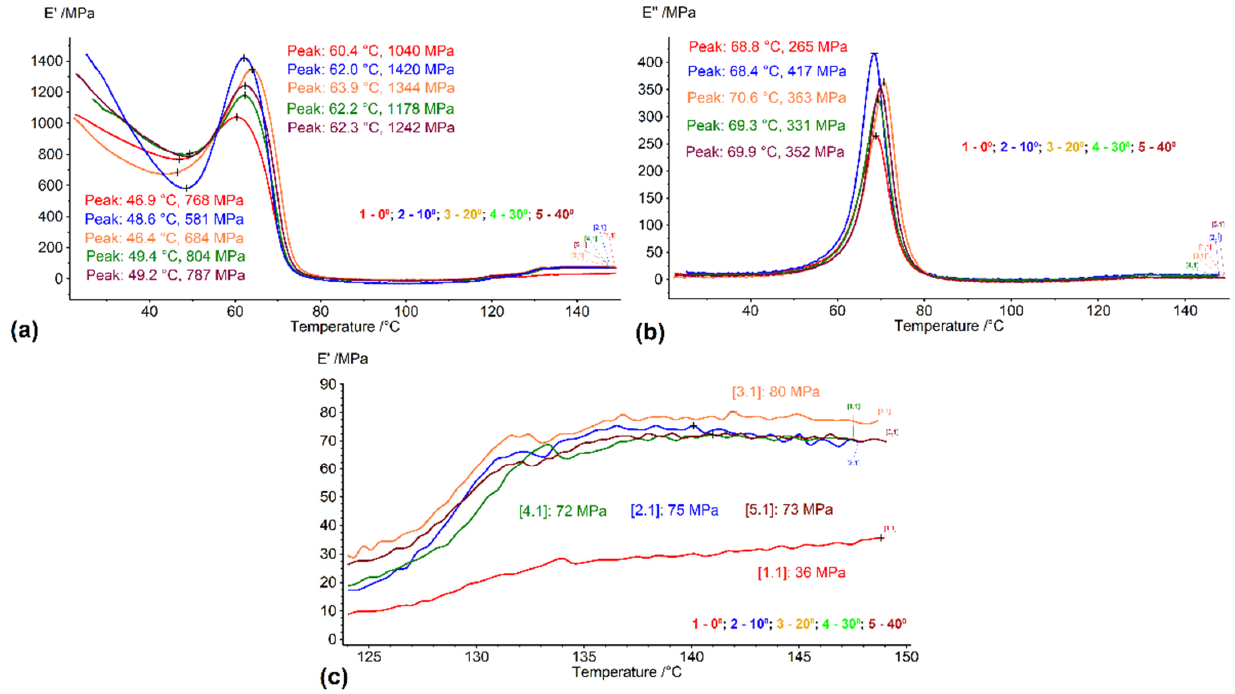
Figure 7. DMA diagrams recorded during the heating of 3D printed specimens: ( a ) variation in storage modulus; ( b ) variation in loss modulus; ( c ) details of the variation in storage modulus between 125 and 150 °C.